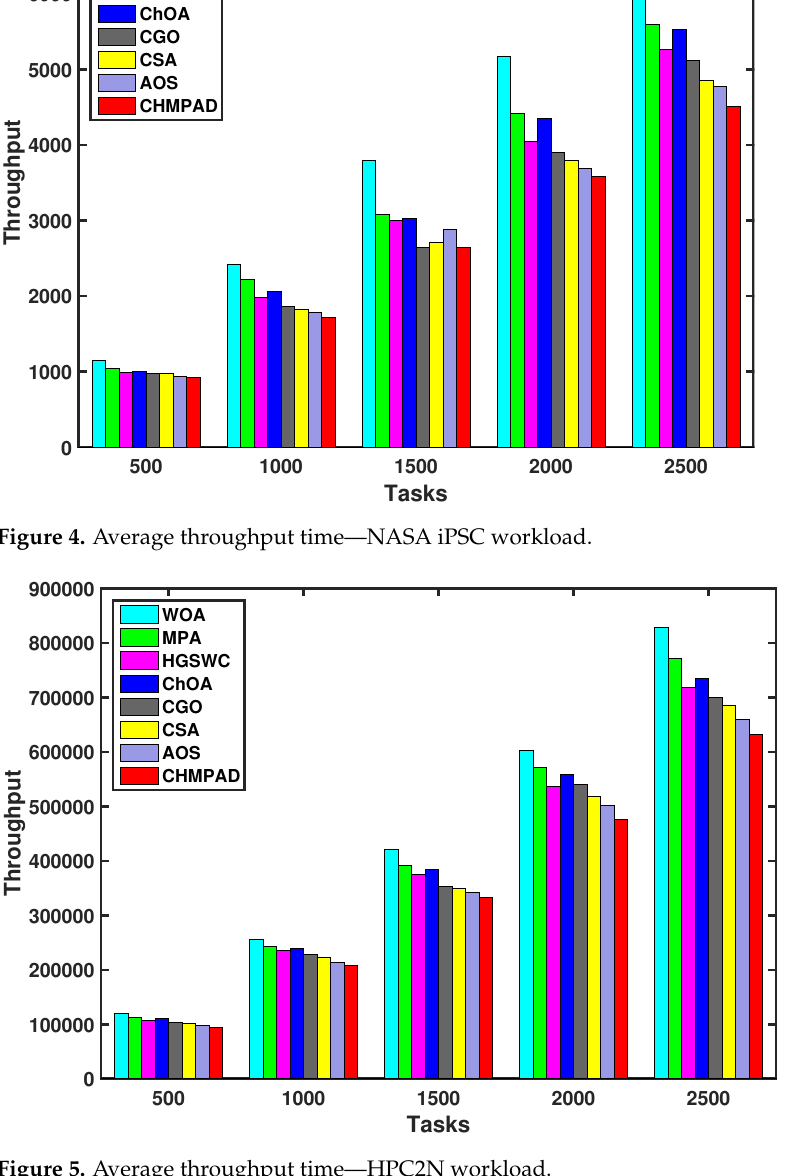
Figure 5. Average throughput time—HPC2N